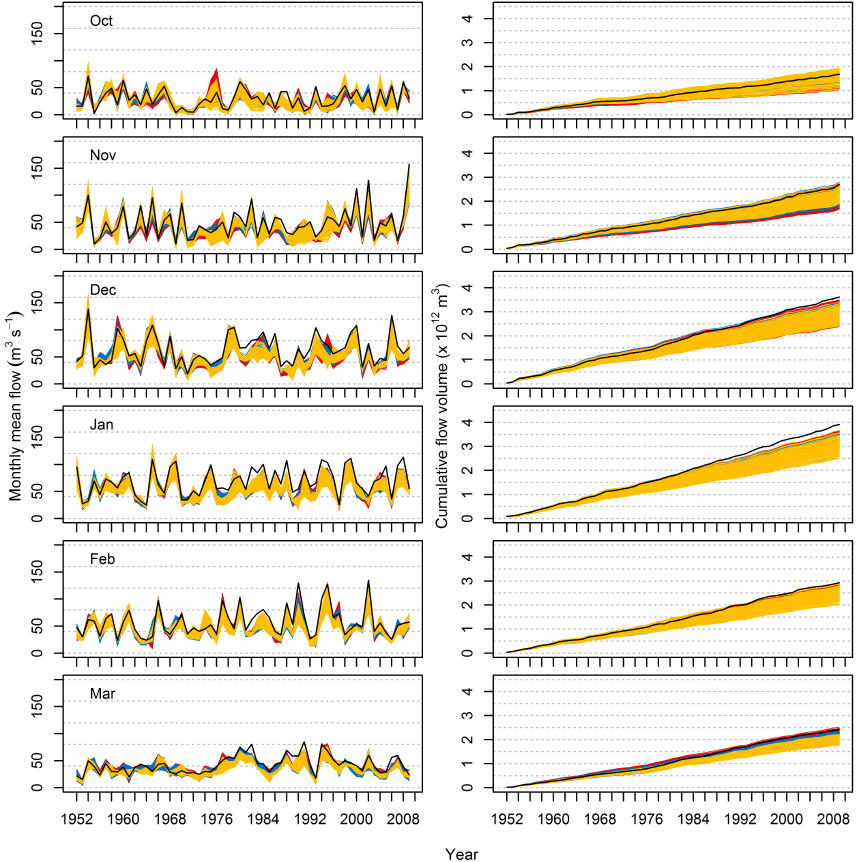
Figure 7. As in Fig. 6 but for the winter half-year (October to